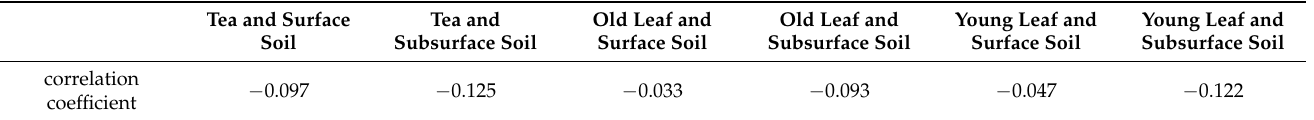
Table 5. The correlation coefficient of Hg content between soil and tea